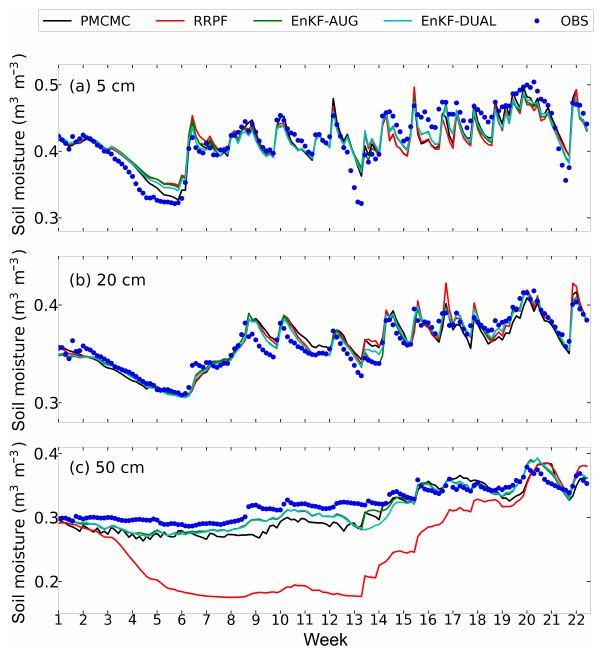
Figure 3. Assimilation period: observed (blue dots) and VIC-3L predicted time series (solid lines) of soil moisture content at depths of (a) 5, (b) 20, and (c) 50cm in the Rollesbroich site. Color cod- ing is used to differentiate between the results of PMCMC (black), RRPF (red), EnKF-AUG (green), and EnKF-DUAL (cyan). The first days of weeks 1 and 22 are 1 March 2012 and 26 July 2012,